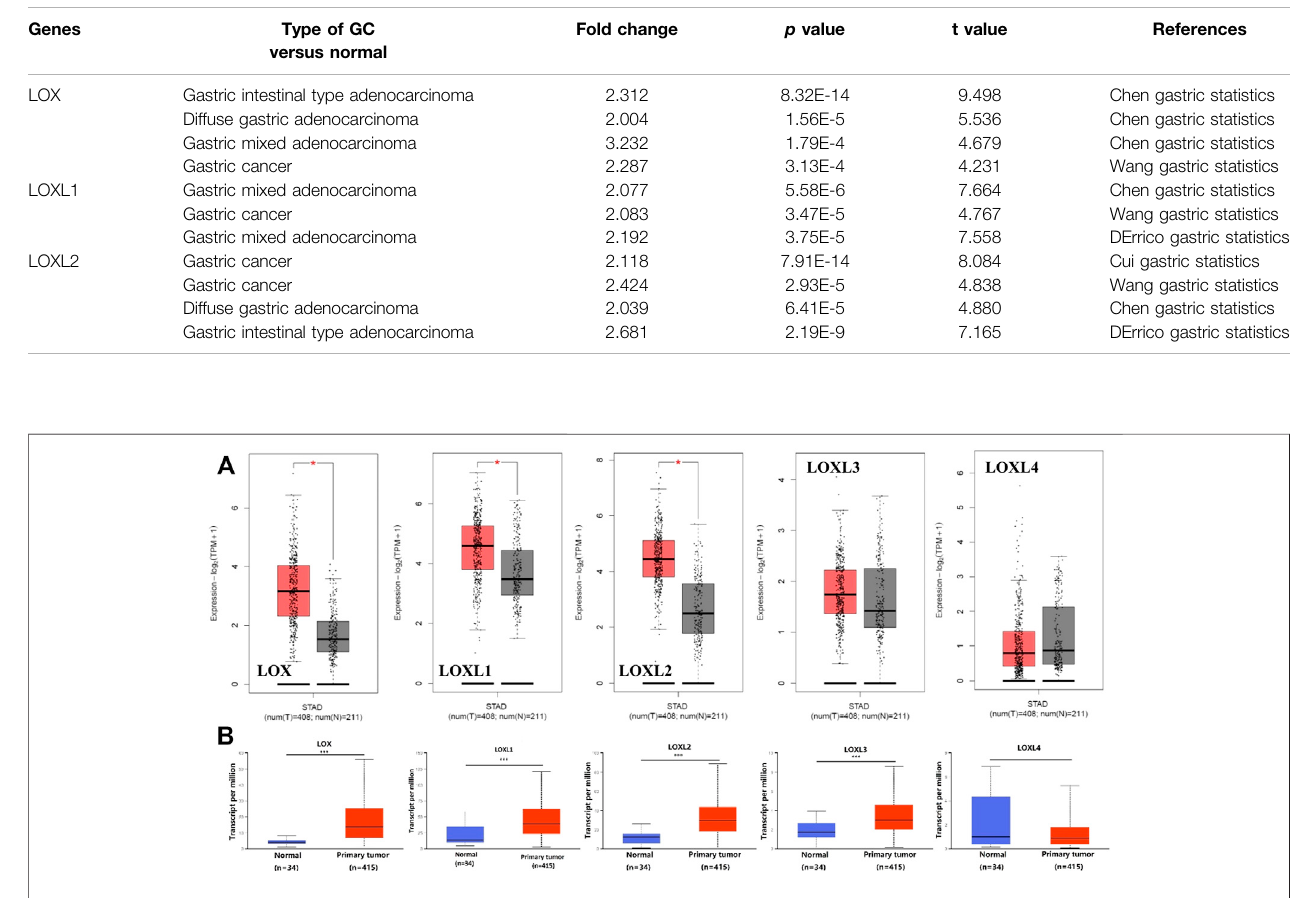
FIGURE 2 | Boxplot showing the expression levels of LOX family inGC. (A) GEPIA analysis. The number of normal samples are 211 (grey box), and number of primarytumorsamplesare408(redbox),redstarmeans p < 0.01; (B) UALCANanalysis.Thenumberofnormalsamplesare34(bluebox),andnumberofprimarytumor samples are 415 (red box) *** p <